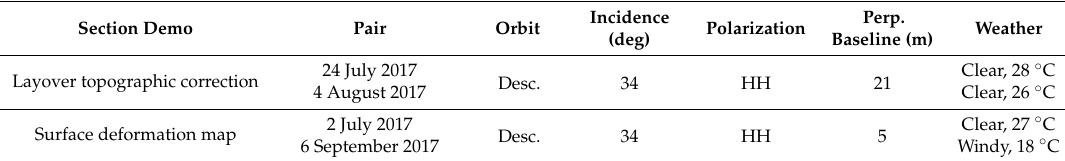
Table 4. Mount Currie presented interferograms.